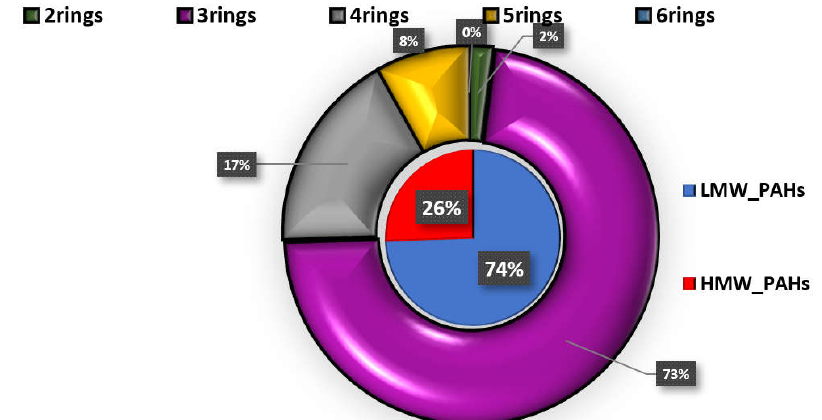
Figure 4. Distribution of HPAHs and LPAHs in cases’ serum.